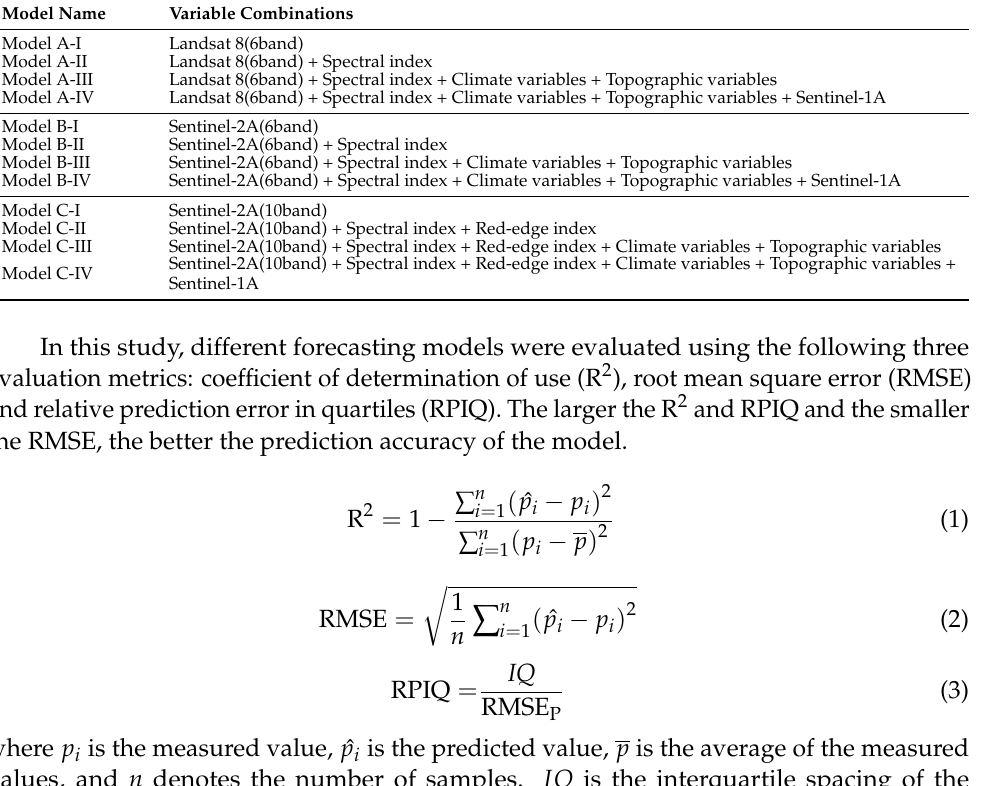
Table 5. Details of the Landsat 8 and Sentinel-2A modeling strategies.